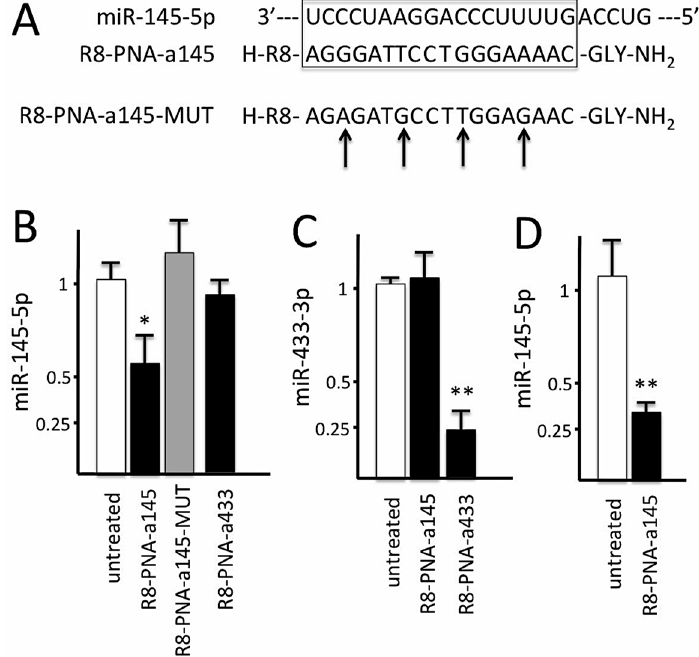
Figure 3. ( A ) Sequences of the R8-PNA-a145 and the mutated R8-PNA-a145-MUT. The G- > A, T- > G and A- > G mutations are arrowed. The box localizes the regions of full complementarity between miR-145-5p and R8-PNA-a145 sequences; ( B , C ). Inhibition of miR-145-5p ( B ) and miR-433-3p ( C ) hybridization signals in Calu-3 cells treated for 72 h with R8-PNA-a145 ( B , C ), mutated R8-PNA-a145-MUT ( B ) and R8-PNA-a433 ( B , C ) molecules (2 µ M, as indicated); ( D ) Inhibition of miR-145-5p in NuLi-1 cells treated for 72 h with R8-PNA-a145 (2 µ M). Results shown represent the average ± standard deviation (S.D.) obtained in at least three independent experiments. * = p < 0.05; ** = p < 0.01.